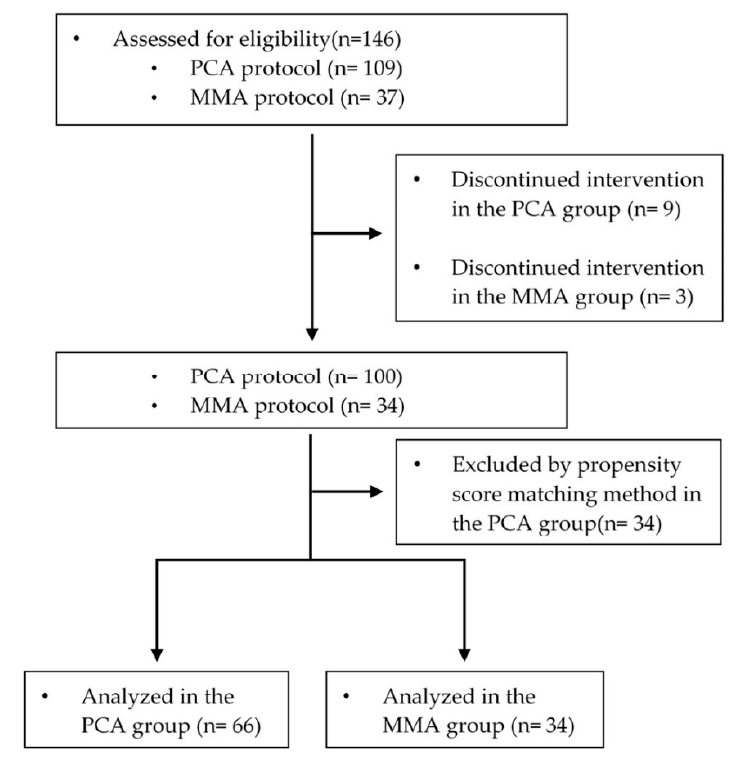
Figure 1. Study design and flowchart